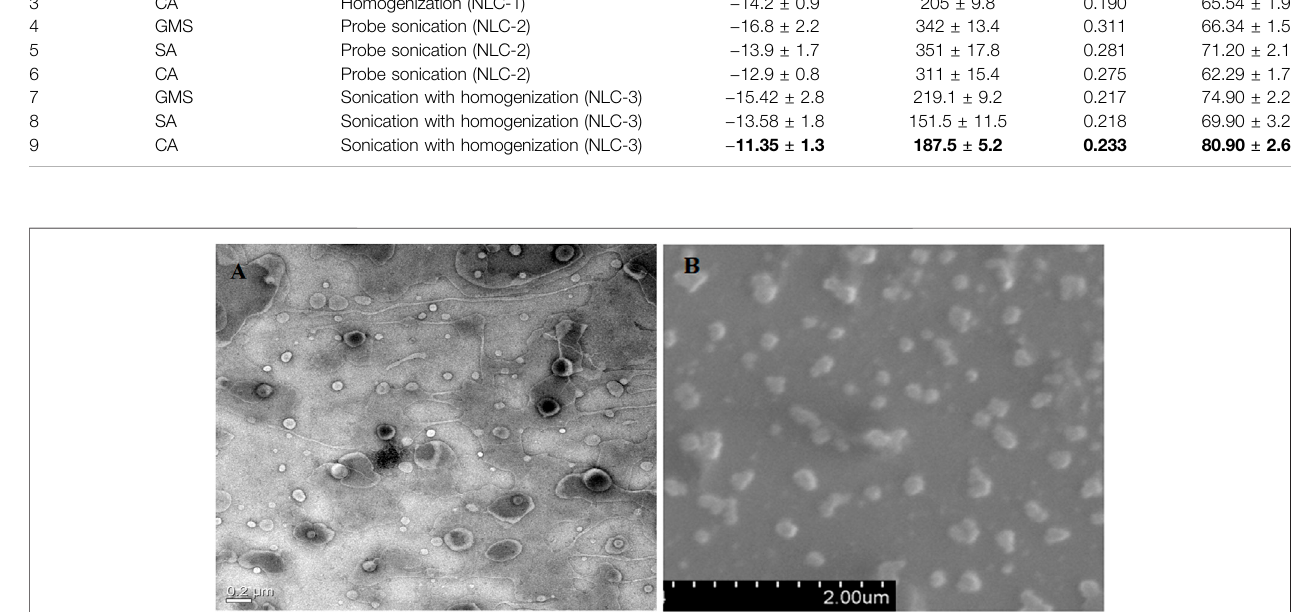
FIGURE 2 | Microscopic analysis of shape and size of prepared formulations. (A) HR-TEM analysis and (B) SEM analysis of ACE-loaded CA-NLCs.